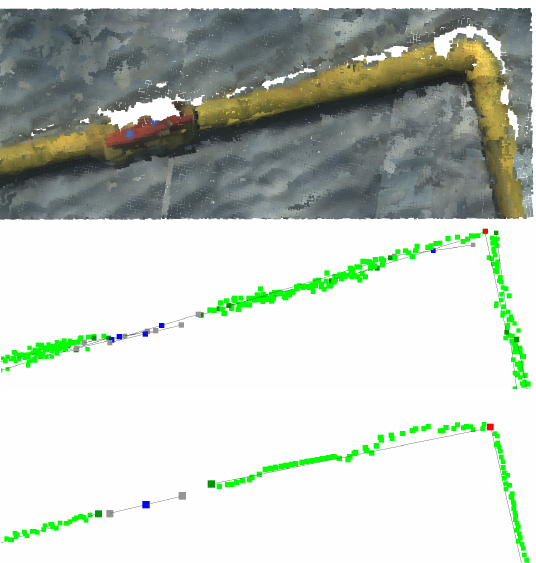
Figure 10. IUA implementation. Top : Overlapped point clouds. Middle : Overlapped extracted information from IEA. Bottom : Unified information from IUA.